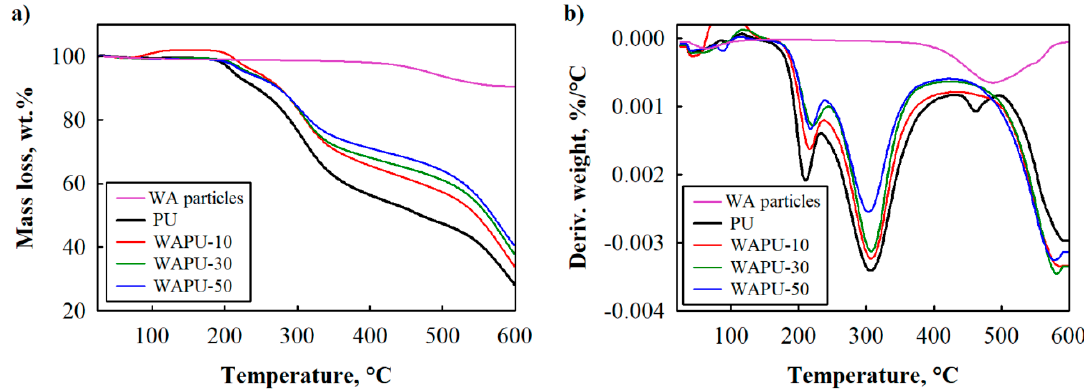
Figure 2. Thermal stability of PU and WAPU foams: ( a ) thermogravimetric analysis (TGA) and ( b ) differential thermogravimetry (DTG).